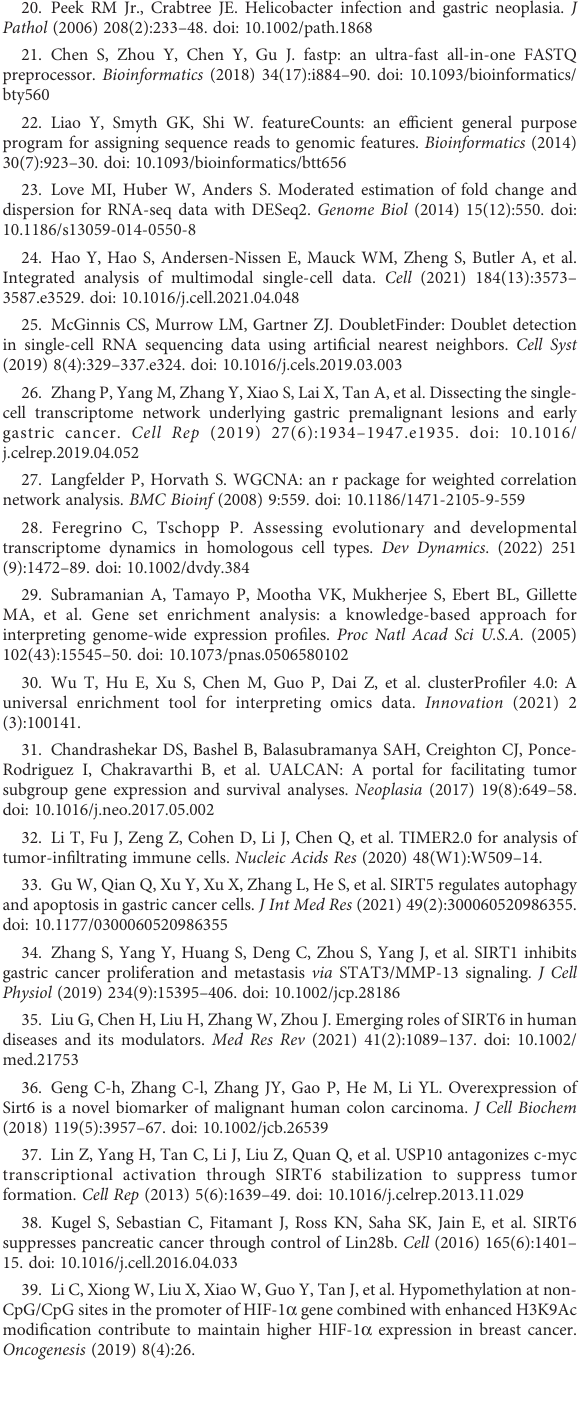
survival analysis of top 9 genes negatively correlated with SIRT6 . Figure S9 showed the exploration of genes ’ immunostaining in control and GC tissues in the Human Protein Atlas. The genes were those negatively correlated with SIRT6 in Figure